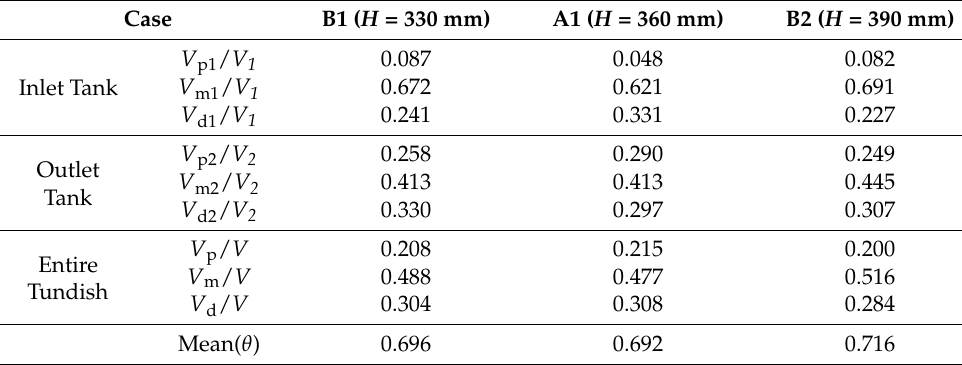
Table 7. Water model experiment results of Cases B1, A1 and B2.